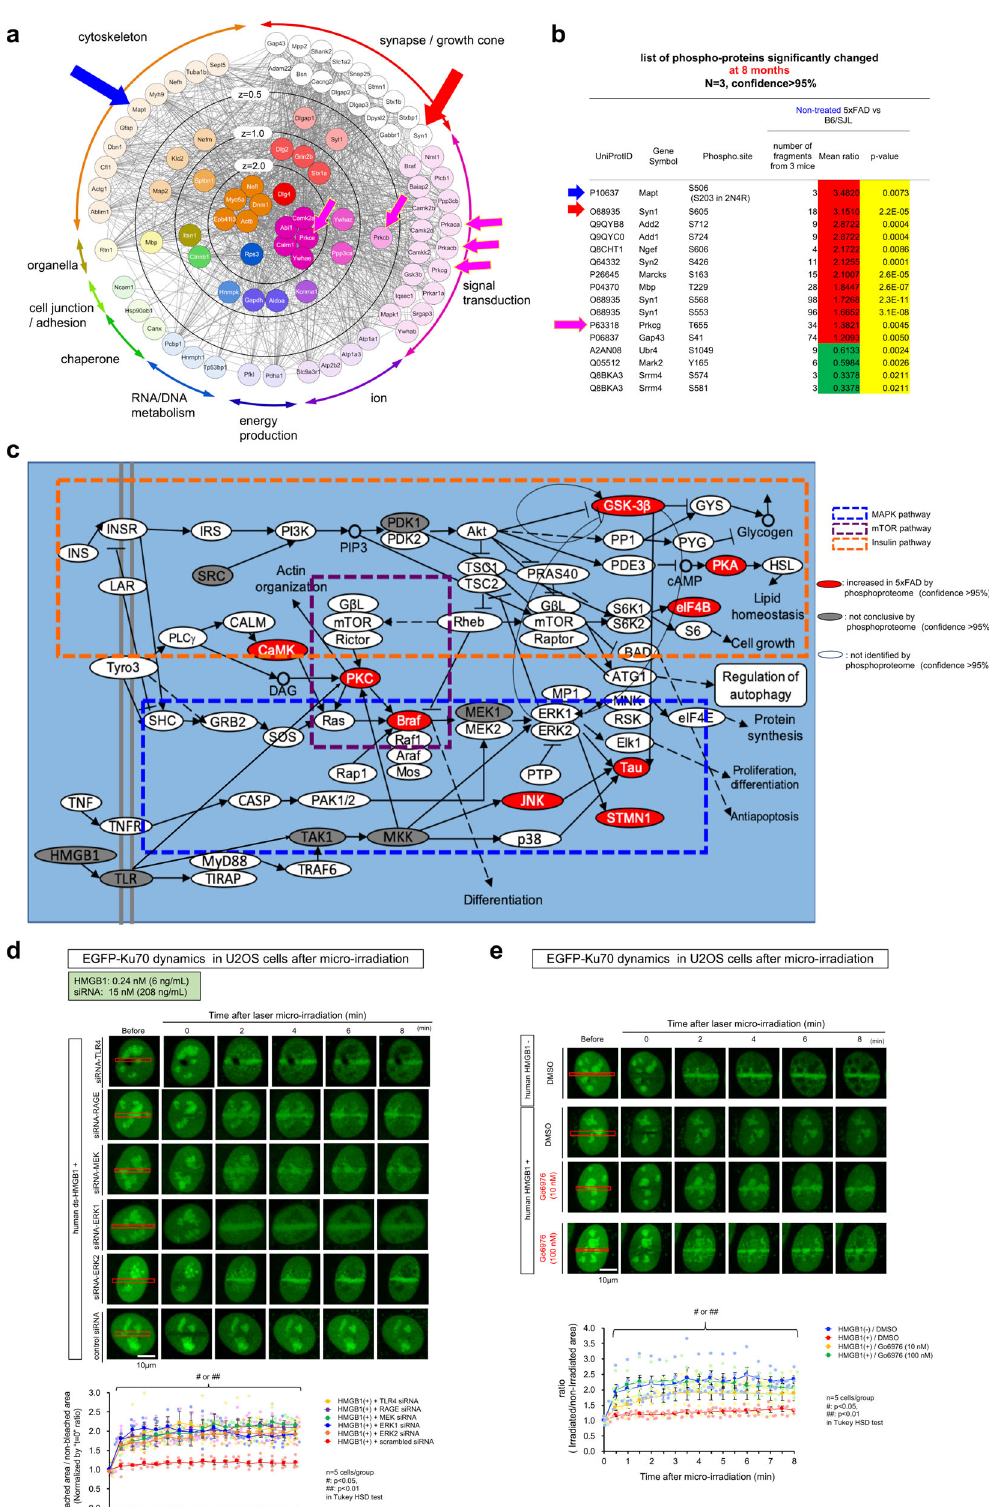
non-treated B6/SJL mice, non-treated 5xFAD mice, and HMGB1- Ab-treated 5xFAD mice (Fig. 4). Phosphorylated peptides and proteins detected with a reliability of >95% in our comprehensive phosphoproteome analysis (Supplementary Fig. 5a) were mapped onto PPI network in the case signi fi cantly changed in at least one molecular network of AD mice (Supplementary Fig. 5b), extrac- ted the core signaling network based on the centrality of proteins